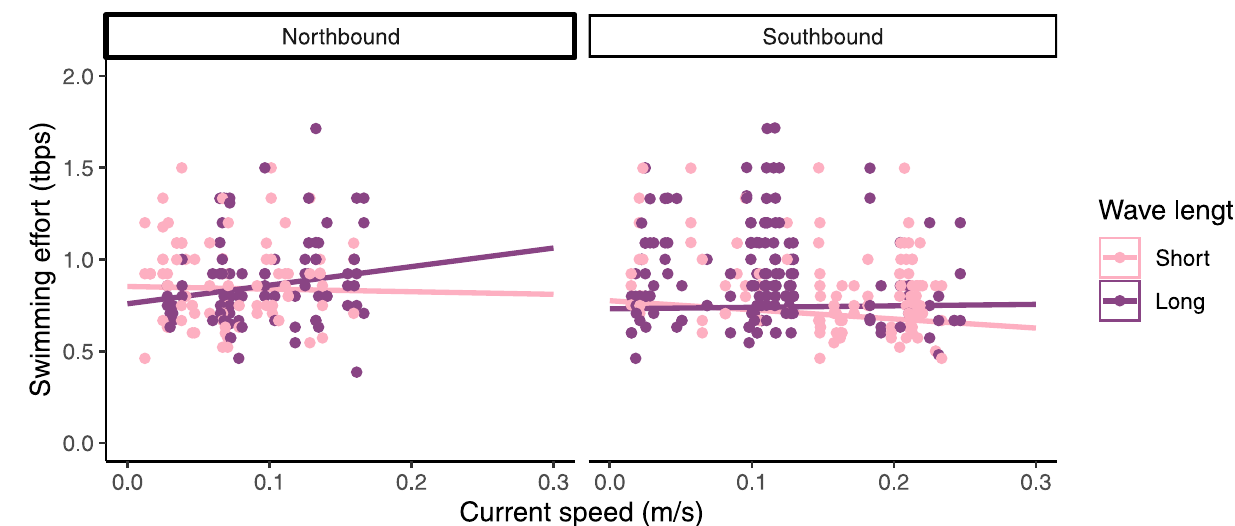
Fig 7. Swimming effort measured in tail beats per second (tbps) over current. Swimming effort in salmon standing on current in northbound and southbound currents. Shading indicates wave length less than 12 seconds (lighter colour) and more than 12 seconds (darker colour).